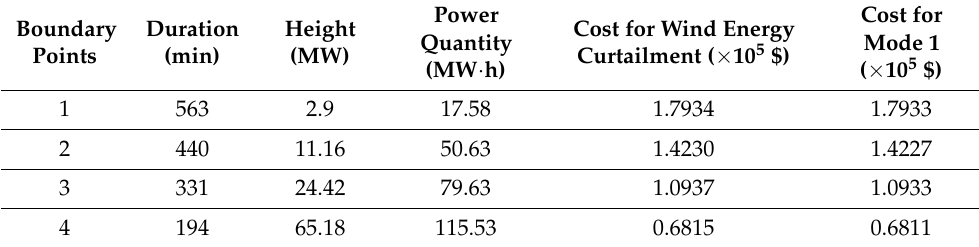
Table 3. Wind energy curtailment boundary with net income as the decision target.